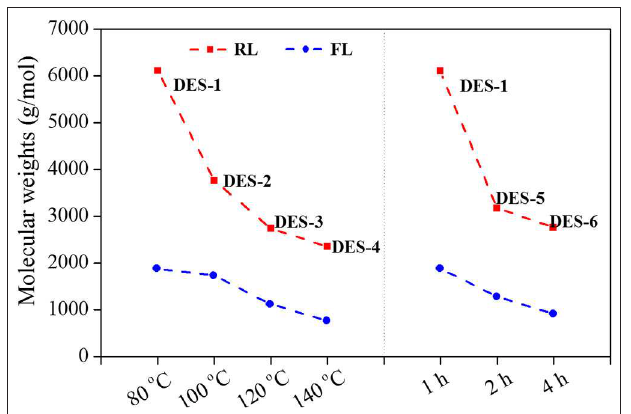
FIGURE 3 | Average molecular weight of regenerated lignin ( RL ) and fragmented lignin ( FL ).